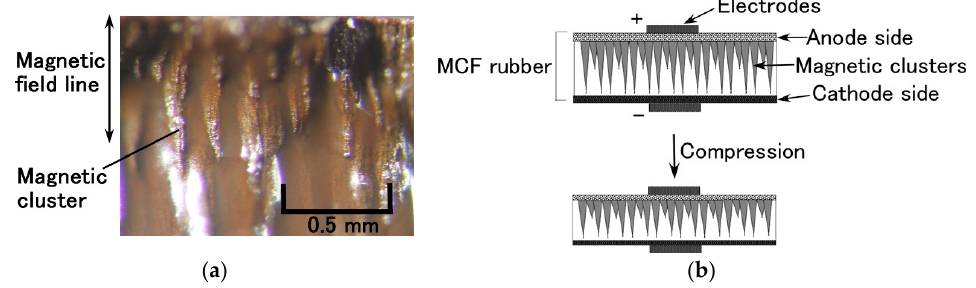
Figure 1. Cross section of Type 1 made of Type A: ( a ) photograph of magnetic clusters created in the vulcanized Type 1 MCF rubber by electric and magnetic fields; ( b ) schematic diagram of the compression of MCF rubber as a piezoelement.